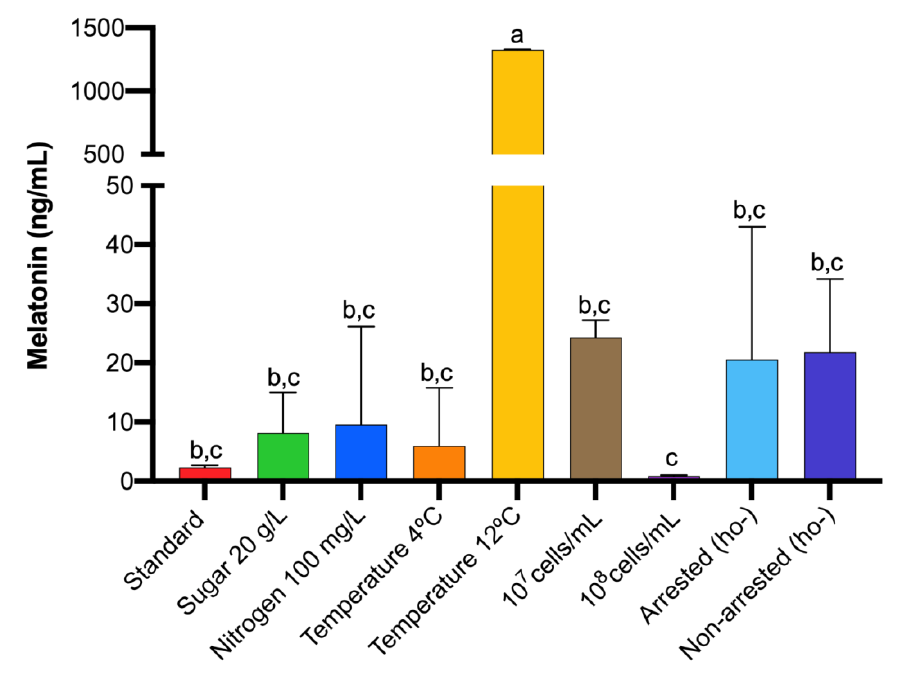
Figure 5. Maximal intracellular melatonin concentration by S. cerevisiae QA23 in several fermentation conditions: Low sugar (20 g/L), low nitrogen (100 mg N/L) concentration, temperature, inoculum amount, arrested and non-arrested cells. Data are expressed in ng/mL per 10 8 cells. Standard fermentation was grape must with 200 g/L sugar and 300 mg N/L, inoculated at 10 6 cells/mL and fermented at 28 °C. Error bars represent SD of n = 3 by ANOVA. Different letters indicate significant differences between conditions, p < 0.05.